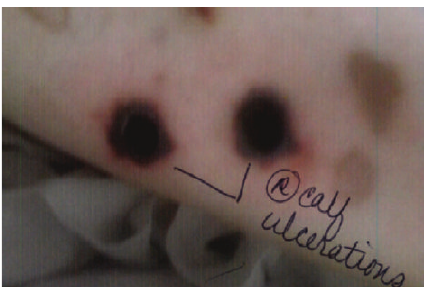
Figure 2: Right calf lesions.